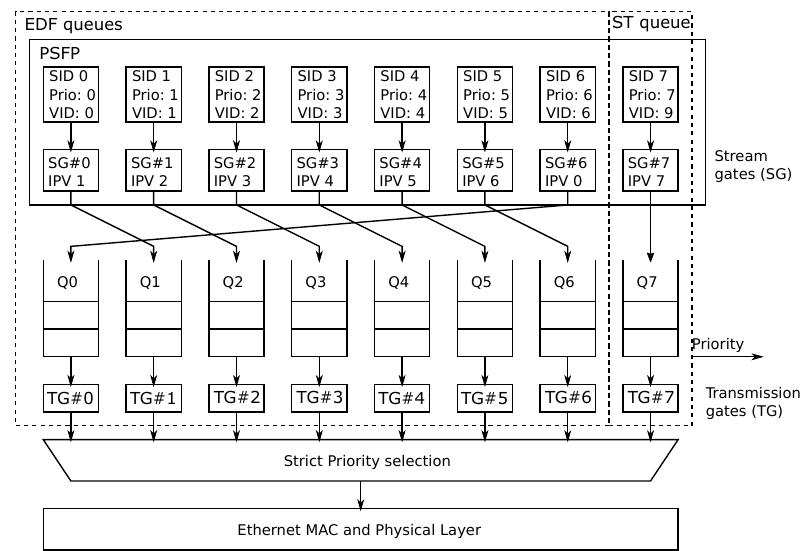
Figure 2. Ethernet port forwarding architecture according to